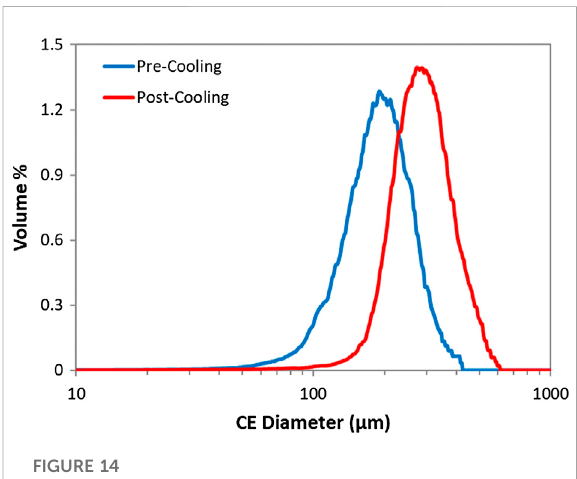
FIGURE 14 Volume weighted circle equivalent diameter distributions from Morphologi G3 for the continuously pre-mixed semi-batch experiment with cooling.